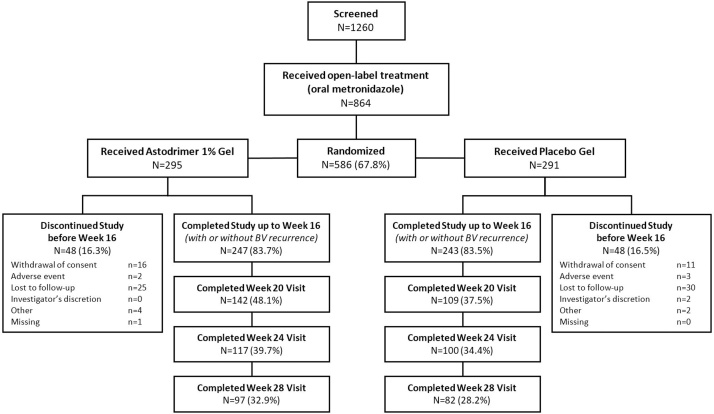
CONSORT diagram.